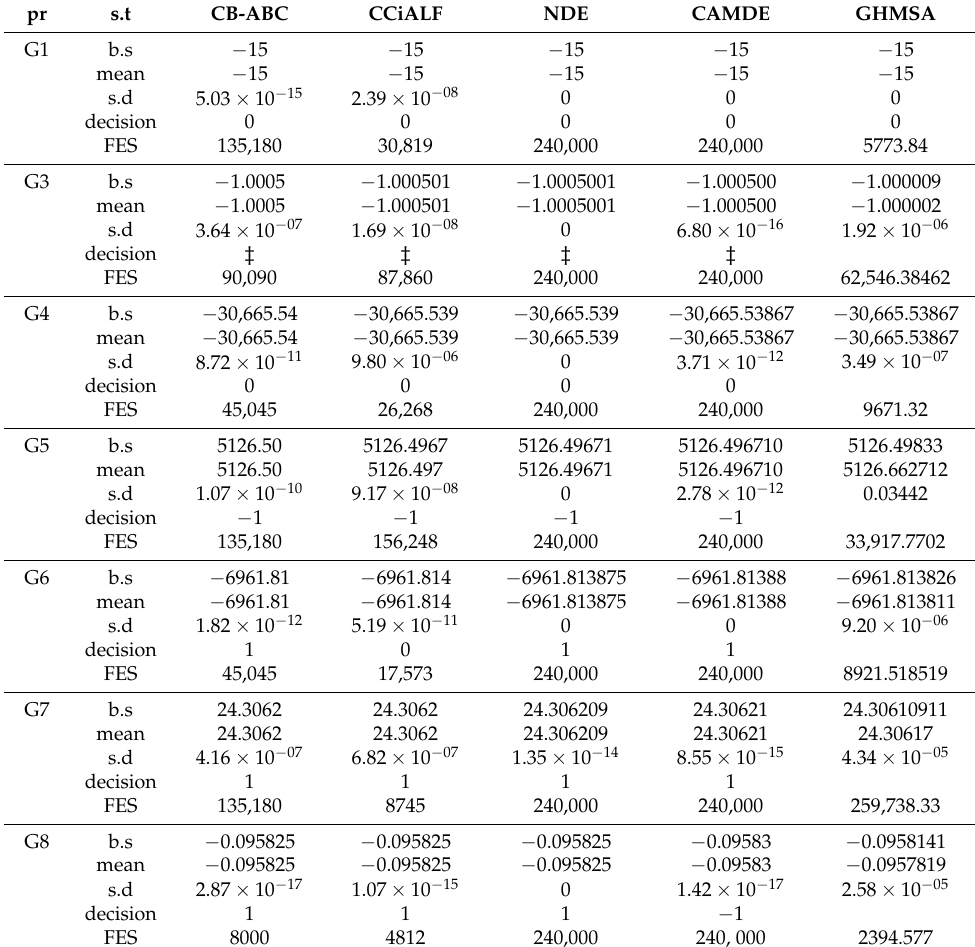
Table 7. Comparison of results for test problems G01 to G08.